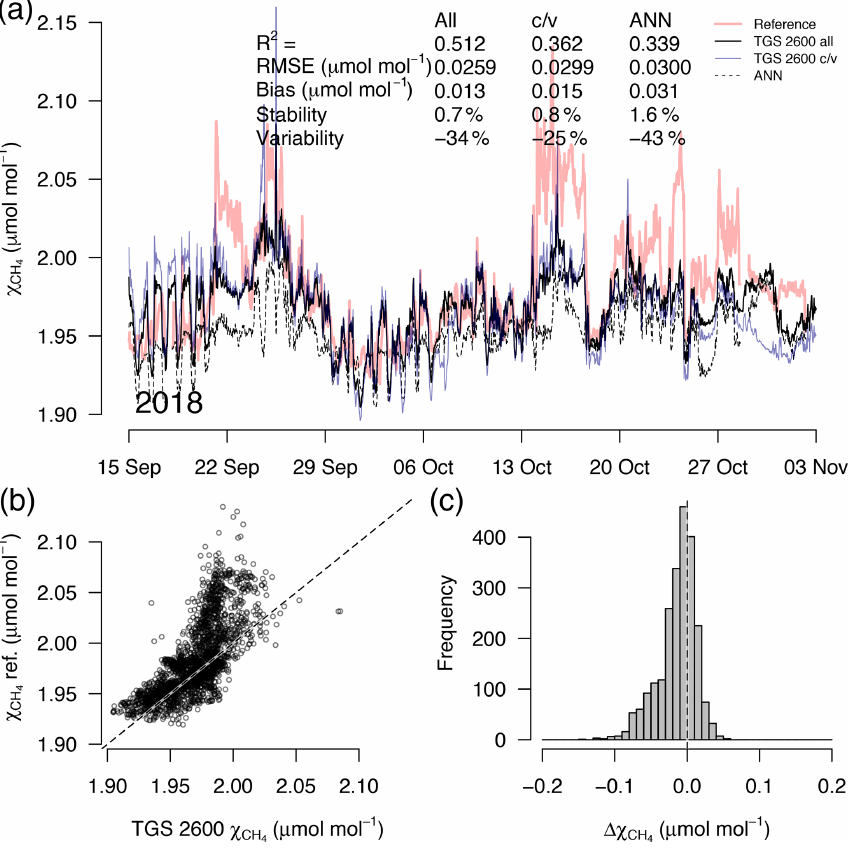
Figure 8. As in Fig. 5 but with measurements from a 7-week period during the transition from fall to early winter. This example belongs to the validation period of the TGS 2600 c/v and ANN fits.